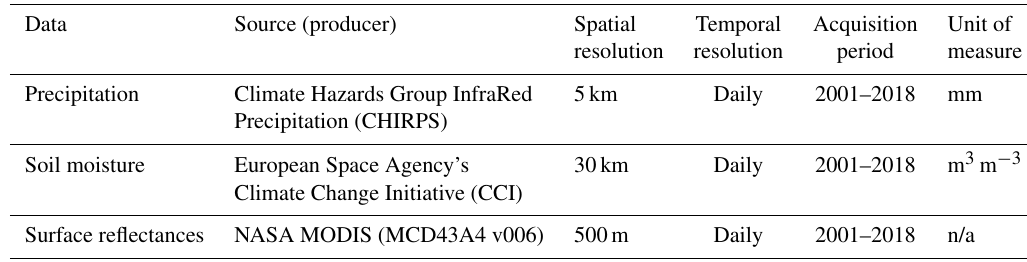
Table 1. Summary of the datasets for the forecast